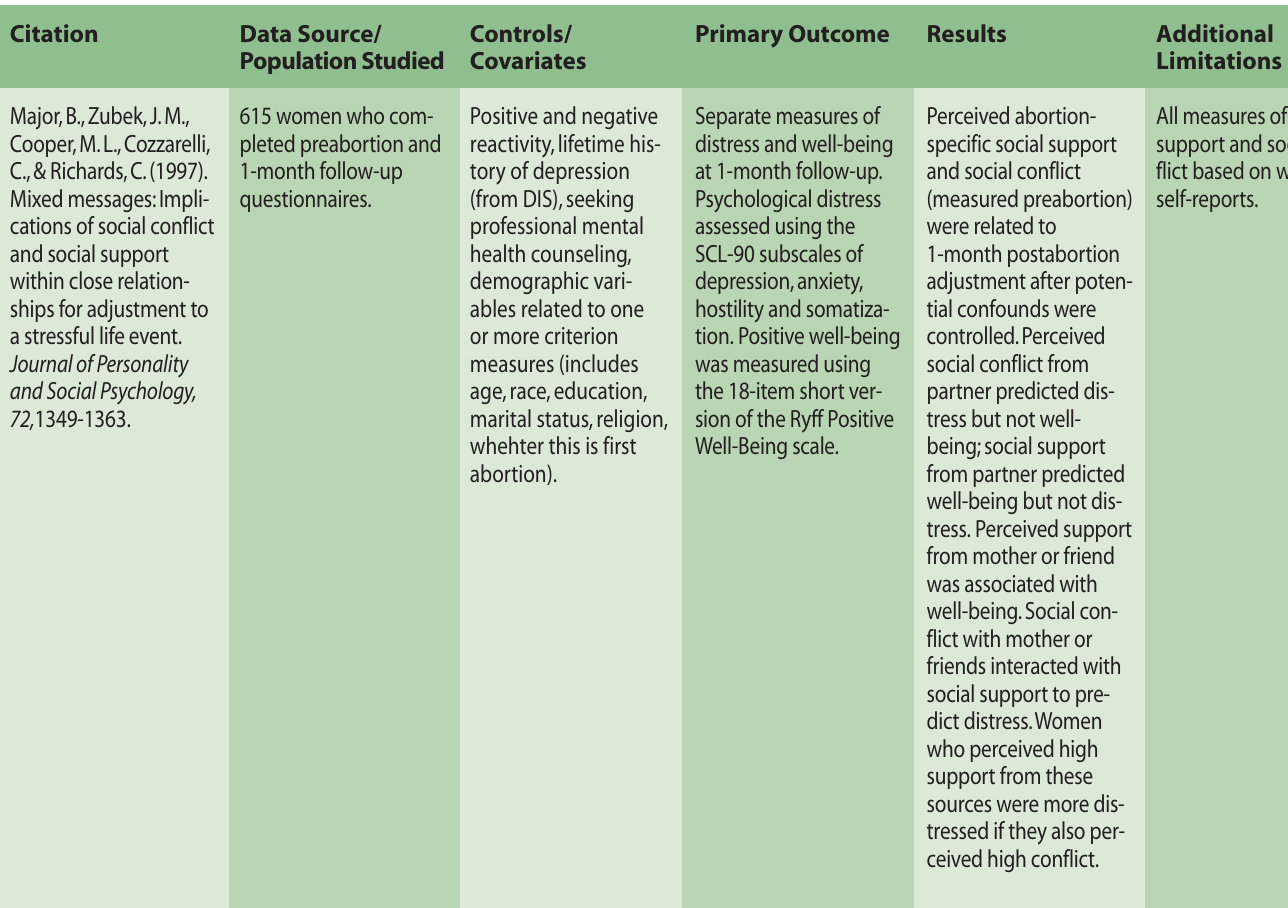
Table 5: U.S.Samples of Abortion Group(s) Only/No